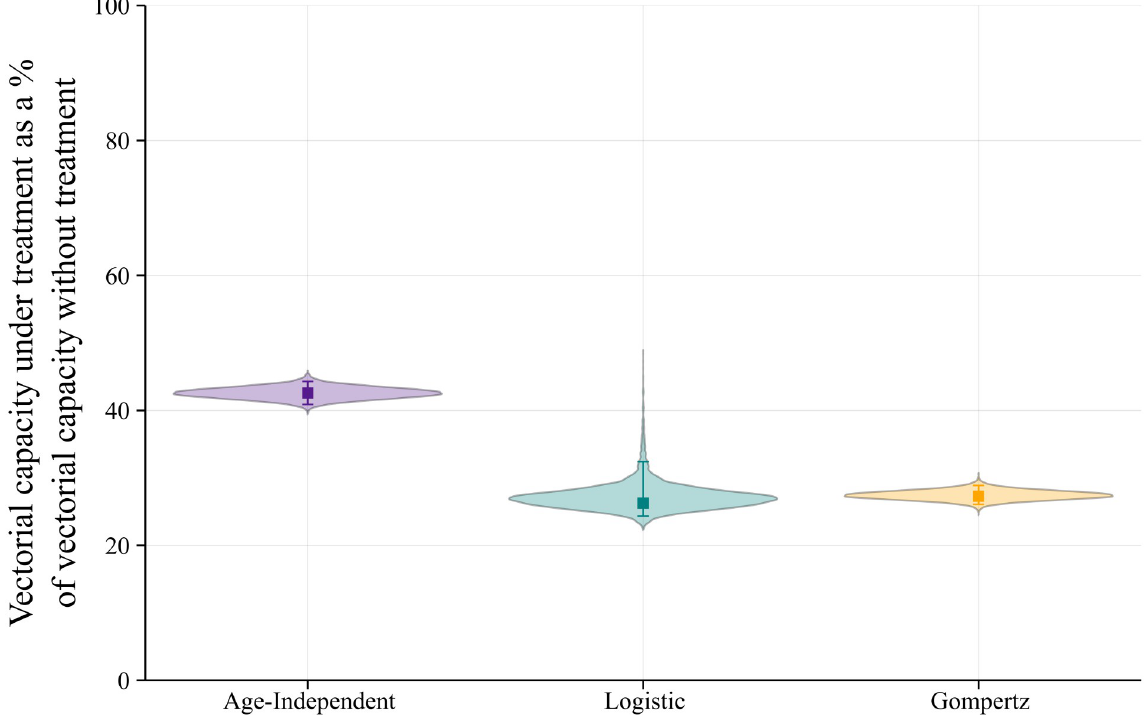
Fig 10. Violin plots showing the relative difference in the vectorial capacity with treatment. The figure shows the full distribution of the results for each function obtained from the Monte Carlo simulations. The error bars represent the 95% confidence interval due to the propagated error of the parameter estimates using Monte Carlo